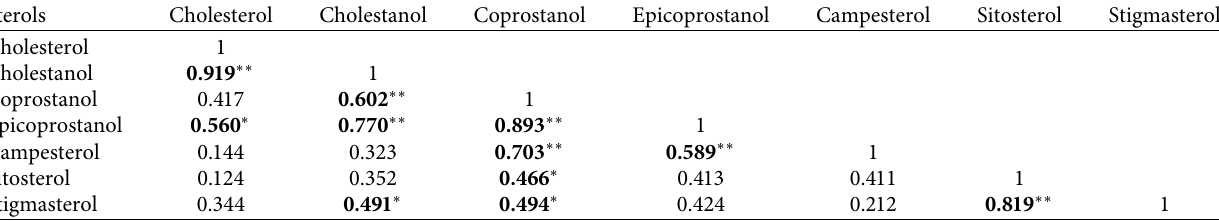
Table 6: Relevance of sterols in sediments of the Guanting Reservoir.